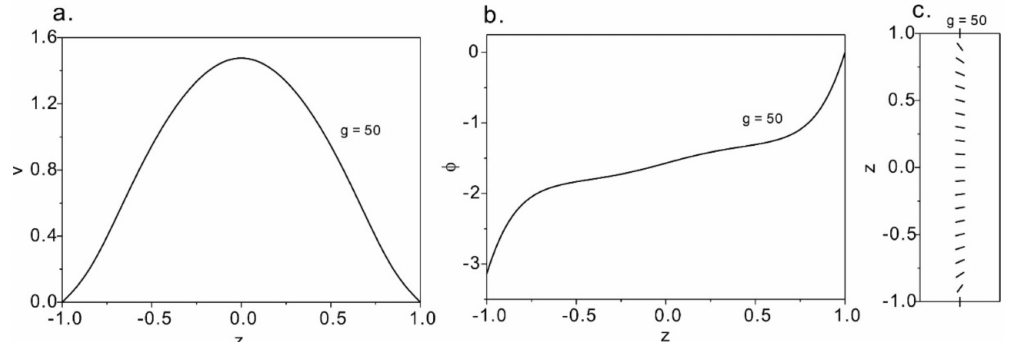
Figure 7. The solution of strong solution at g = 50. ( a ) The velocity profile; ( b ) angle of the director; ( c ) the distribution of the director at g =